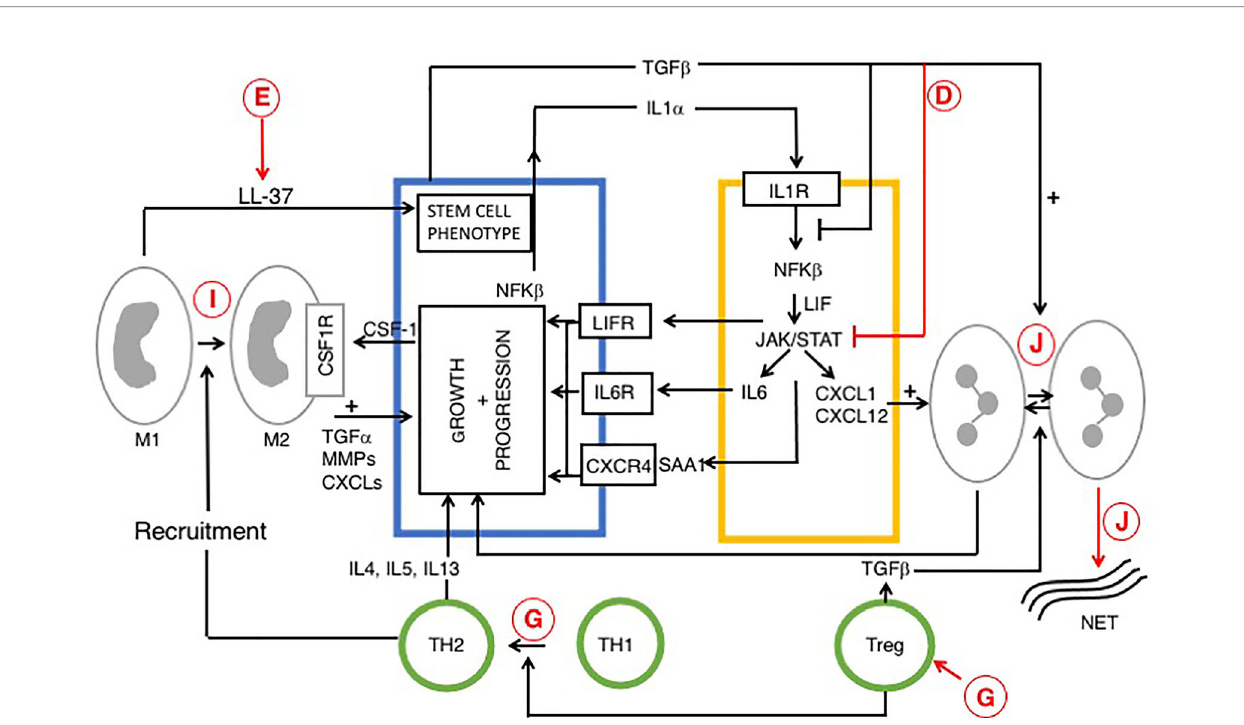
FIGURE 3 | Reciprocal signaling pathways within PDAC and iCAFs, modi fi ed from (170, 180) and role of vitamin D. Tumor cell interactions with immune cells (tumor associated macrophages (TAM), neutrophils and T cells are also indicated. Cells are colored as in Figures 1 and 2 . Stromal/in fl ammatory signaling pathways in fl uence PDAC progression. Growth of PDAC cells is driven by cytokines and growth factors: LIF, IL-6 and SAA1 (derived from iCAFs), IL-4 (from TH2) and TGF a from TAMs. PDAC cells secrete IL-1 a or TGF to drive an iCAF or myo-CAF phenotype. VDAs have direct effects upon cancer, stromal and immune cells and indirect effects upon intercellular signaling pathways. Predicted effects of vitamin D are labeled A-J as described in Table 6 , where labels indicate: D Inhibition of cytokine and pro-in fl ammatory chemokine release; E Increased macrophage production of cathelicidin and cleavage product (LL-37), associated with a cancer stem cell phenotype; G Suppression of immunity: increased Treg activity, activation of Th2 and suppression of Th1 cells; I Anti-tumor M1 phenotype conversion into immune- suppressive, pro-tumor M2 macrophages, and J Decreased neutrophil activity and increased formation of NETs. The role of vitamin D in NET formation